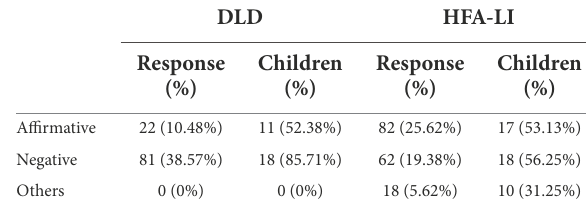
TABLE 5 Number of non-target responses in Structure C.